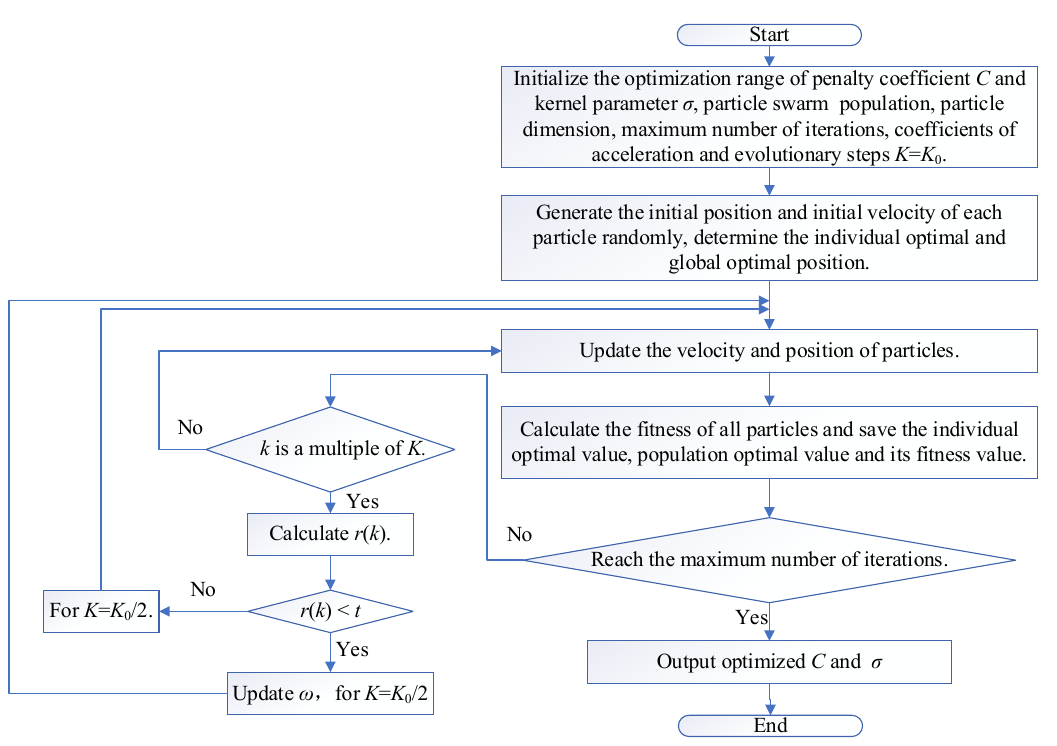
Figure 3. Flowchart of the improved PSO to optimize the parameters of the SVR model.